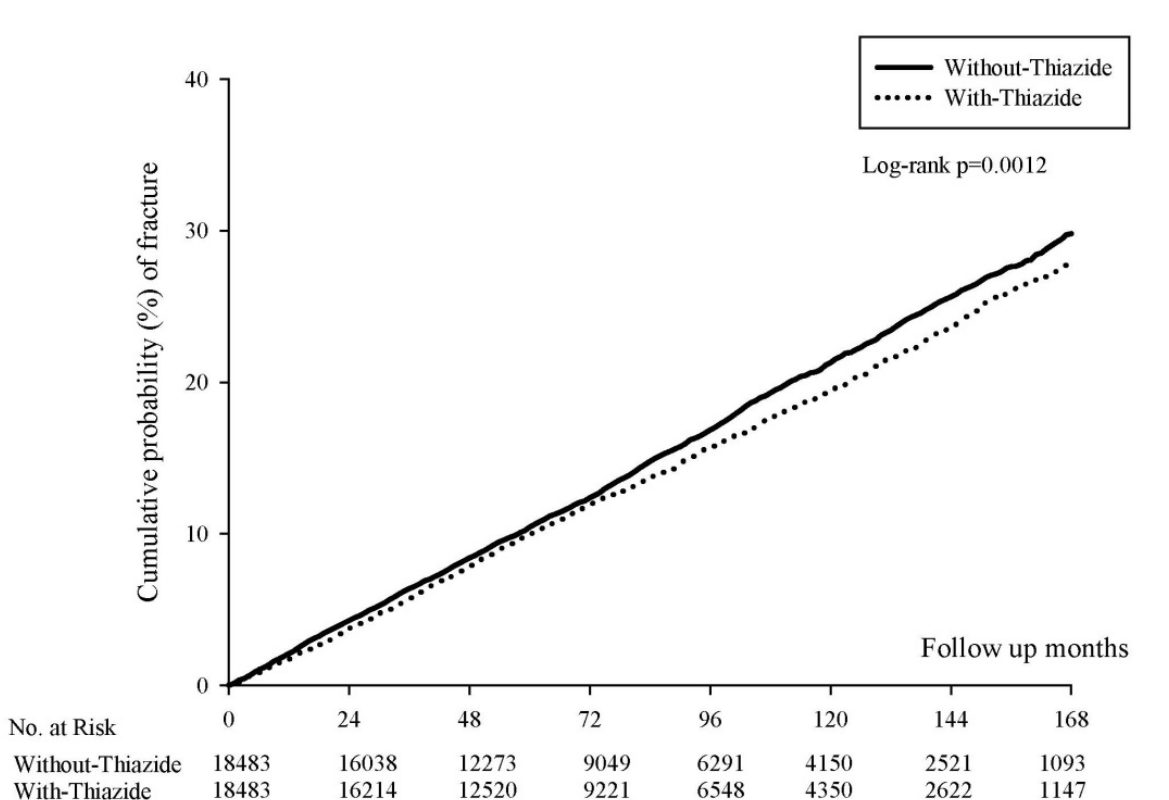
Table 2. Incidence density of fracture.